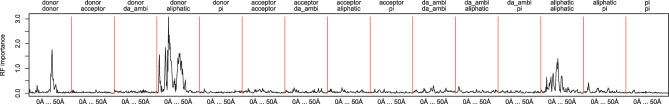
Random Forest Feature Importance Measured by the Mean Decrease in Gini Coefficient